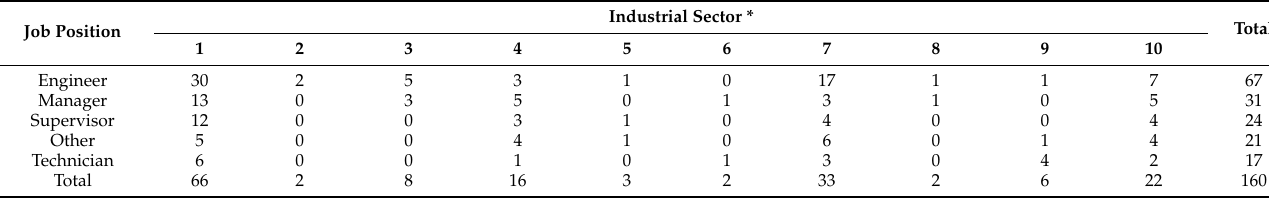
Table 1. Industrial sector vs. job